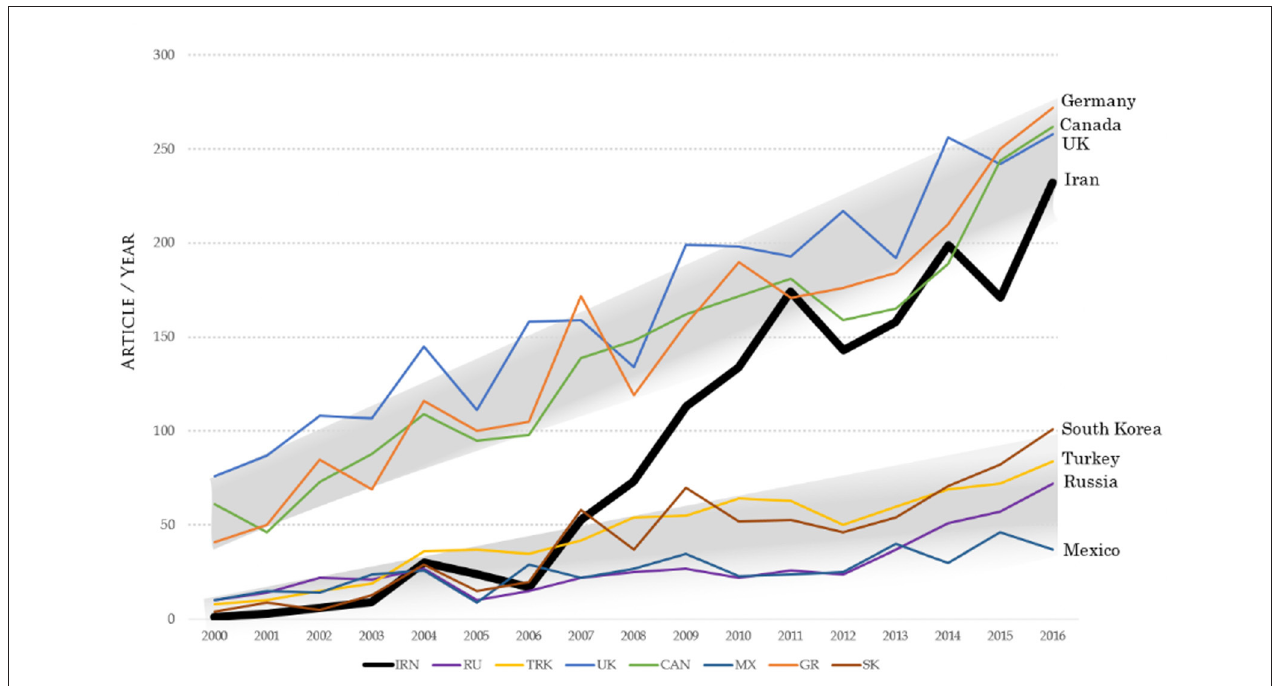
FIGURE 4 | Growth of publication on “water resources”, 2000–2016 (Source: